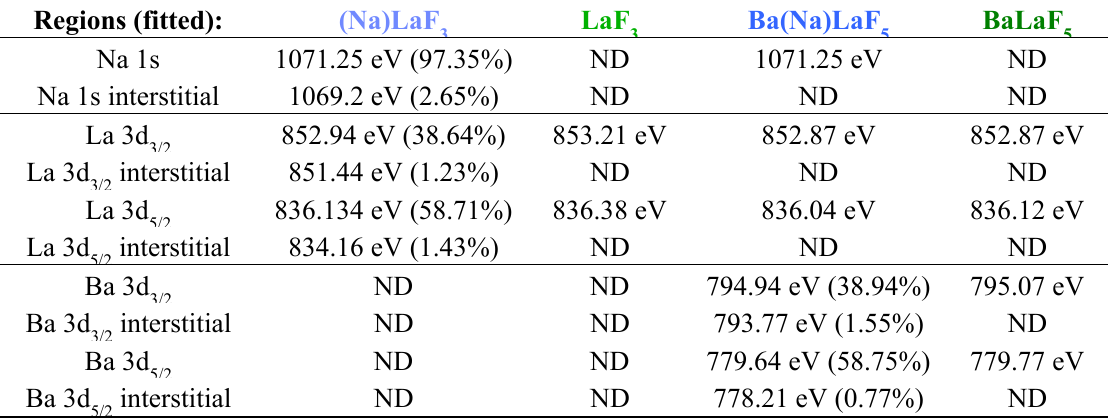
Table 2. X-ray photoelectron spectroscopy (XPS) Na 1s, La 3d, and Ba 3d regions scans binding energies (eV) in (Na)LaF multicomponent Gaussian fits, percentage values listed correspond to the extent of ion incorporation by substitution (primary peak) and insertion into interstitial sites (lower energy component). ND denotes Not Detectable.